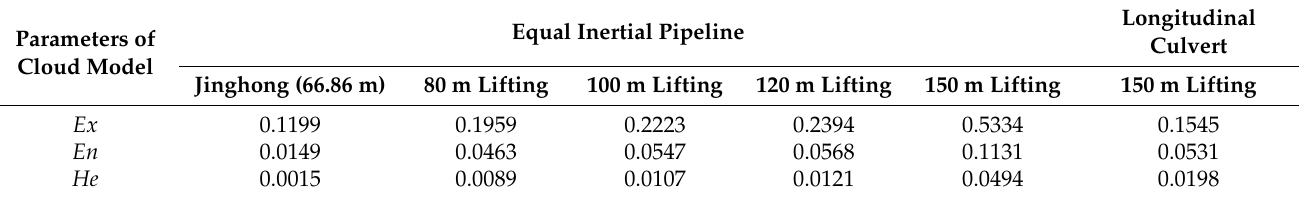
Table 4. Three parameters of water surface deviation from the shafts in the filling–emptying system under the condition of a 150 m lifting